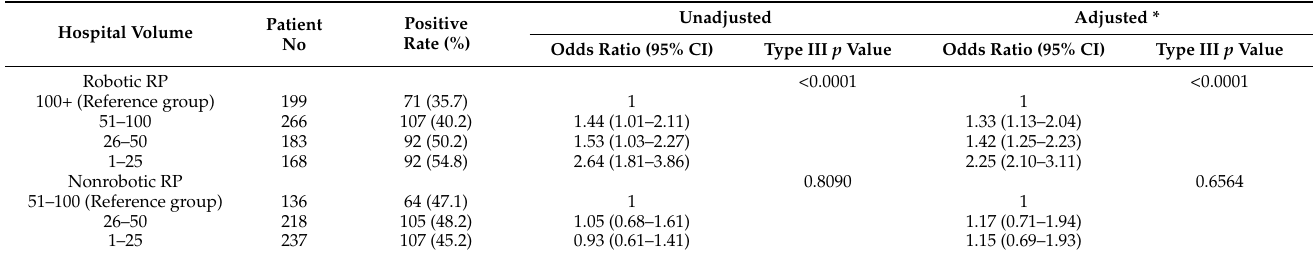
Table 2. Logistic regression comparing positive surgical margin rates stratified by hospital volume for prostate cancer patients receiving robotic or nonrobotic radical